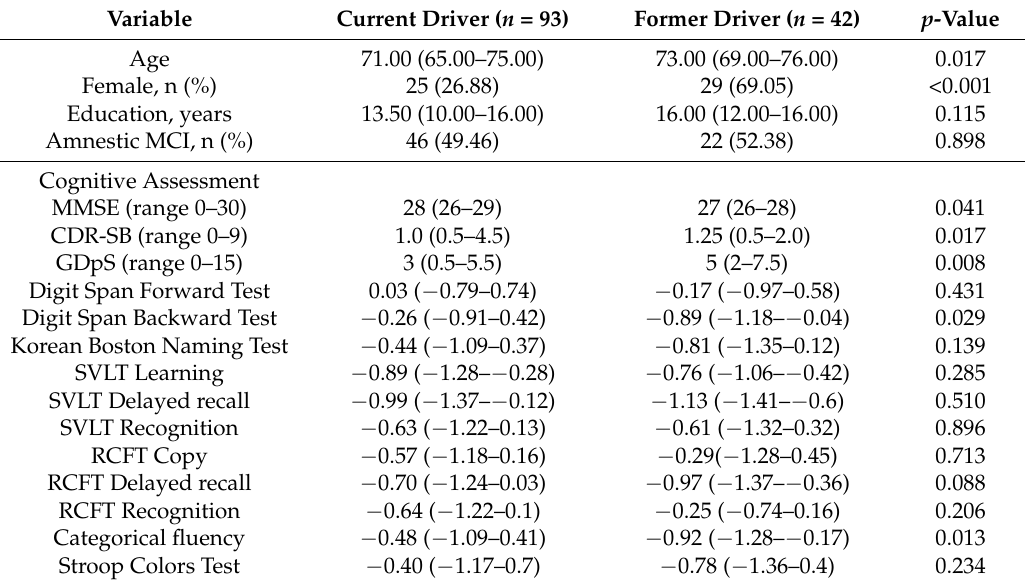
Table 2. Demographic characteristics and cognitive assessments of current and former drivers with mild cognitive impairment